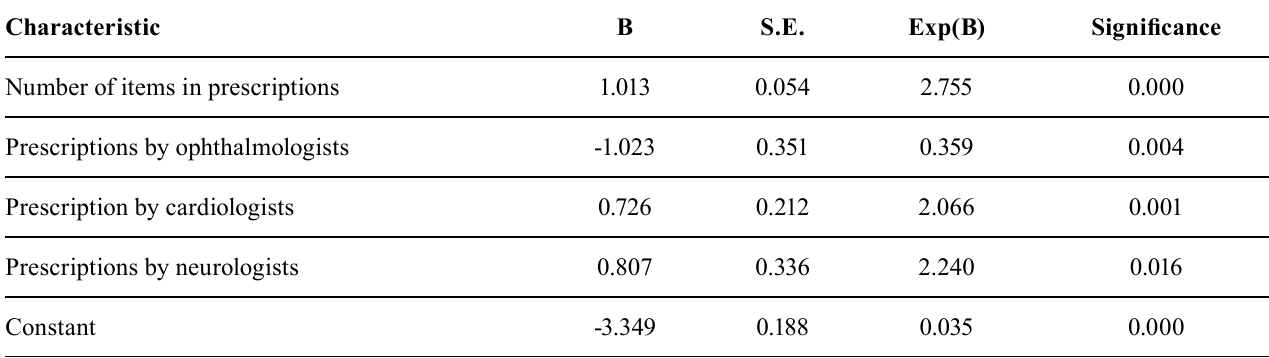
TABLE III – Final model of multivariate logistic regression analysis to identify the independent factors associated with clinically relevant DDIs